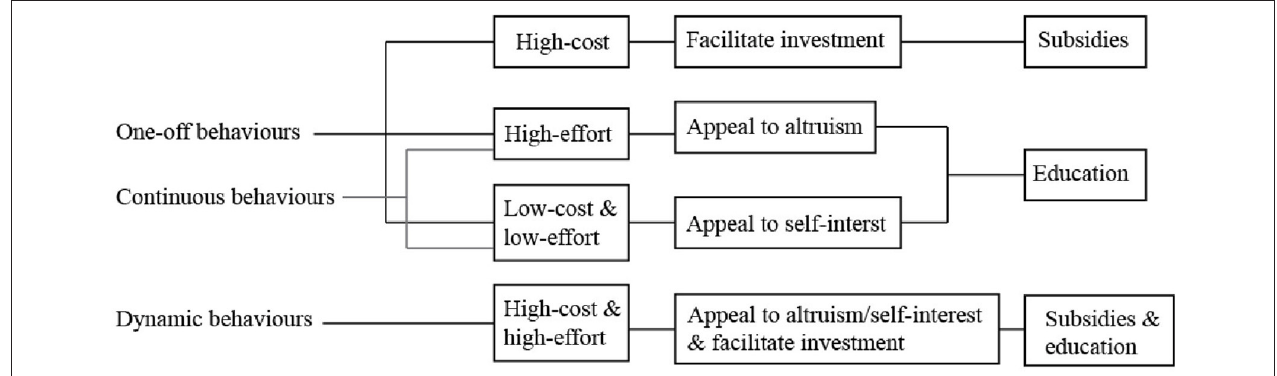
FIGURE 1 | Flow-chart of cost, effort, and interventations for one-off, continuous, and dynamic environmental behaviors.